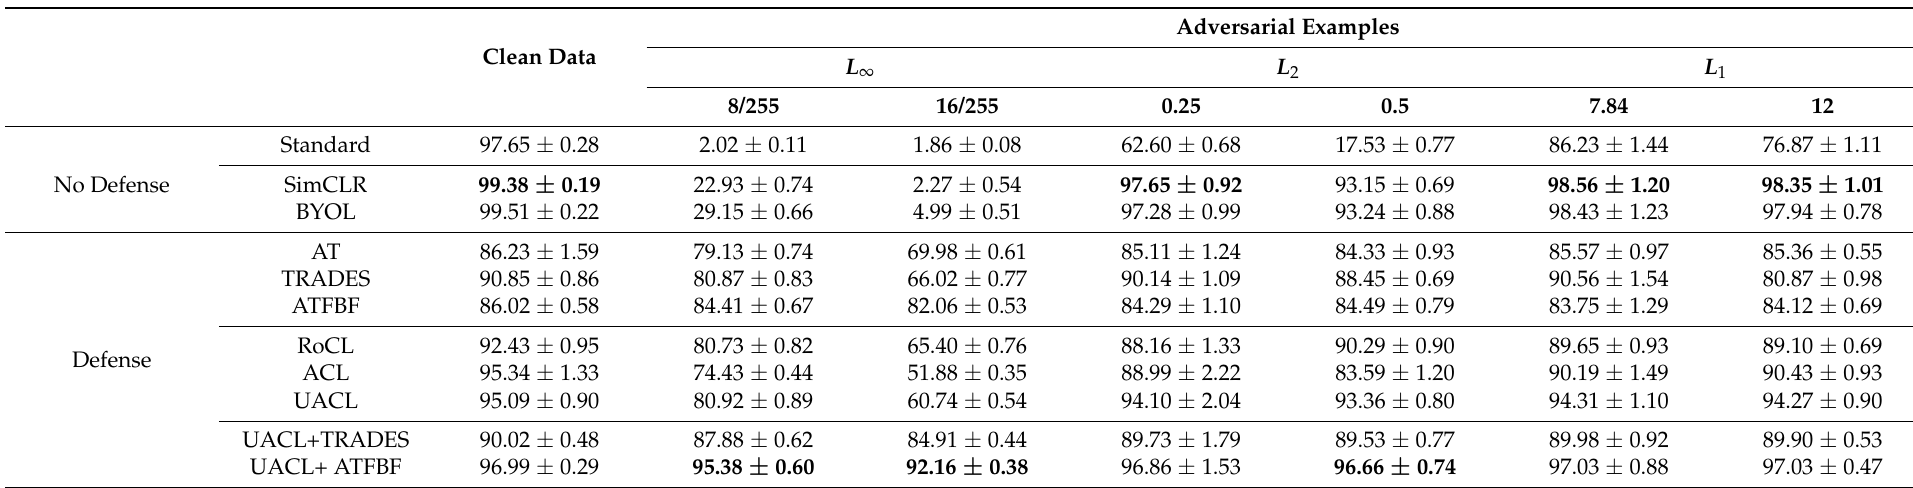
Table 9. Classification accuracy of models (ResNet18) with no-defense or defense methods against PGD adversarial attacks in MSTAR dataset.